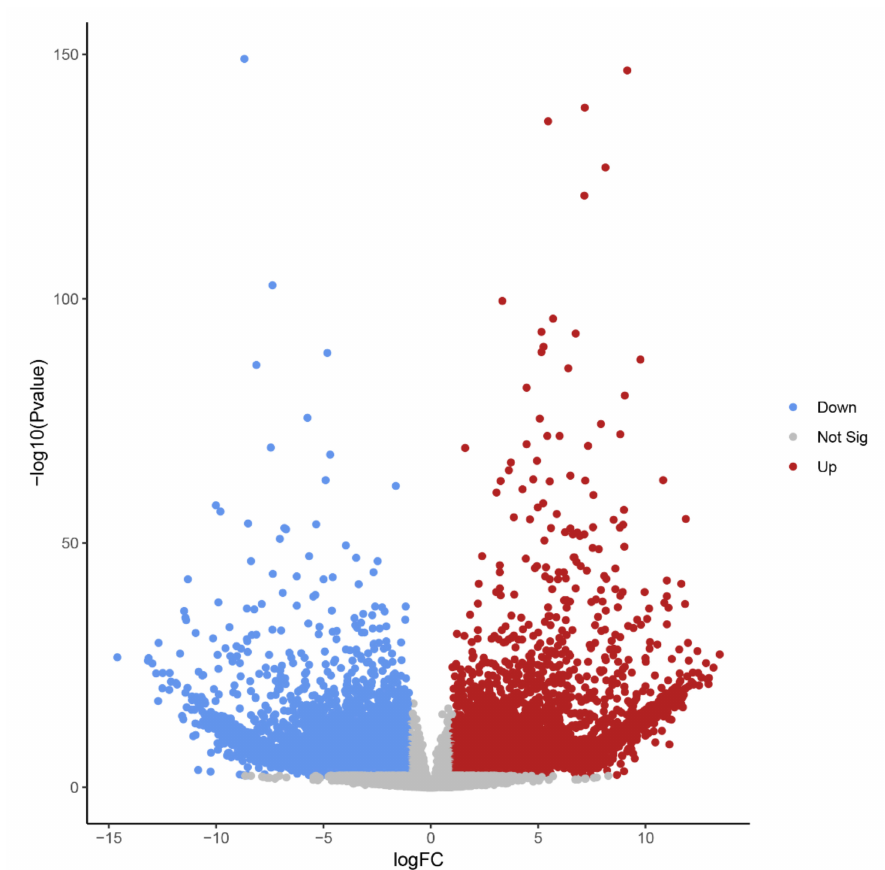
Figure 4. Volcano plot highlighting transcript isoforms di ff erentially expressed during B chromosome elimination in Ae. speltoides (FDR-corrected p -value < 0.01). Red color defines up-regulated and blue defines down-regulated transcript